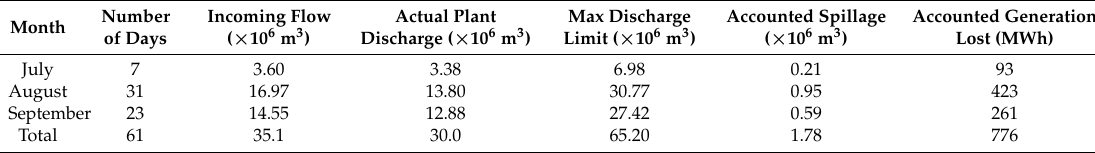
Table 7. Generation data after installation of the computed river flow-based controller (24 July to 23 September